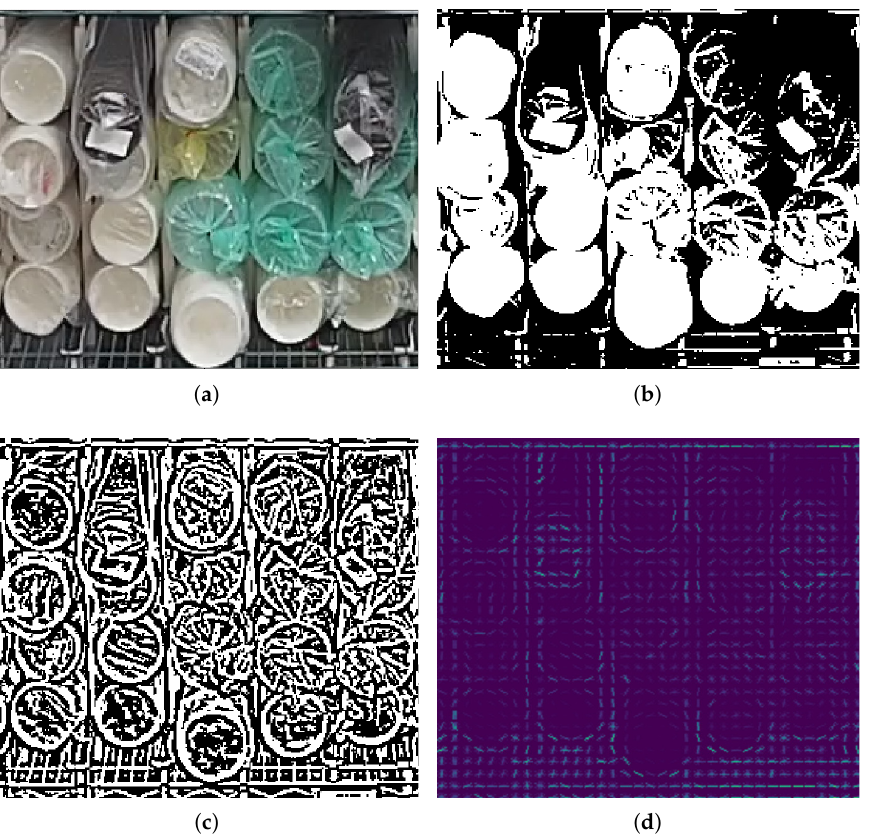
Figure 6. Features extracted by different traditional methods. ( a ) Input image. ( b ) Binarization result with Otsu global threshold. ( c ) Binarization result with adaptive threshold. ( d ) HOG